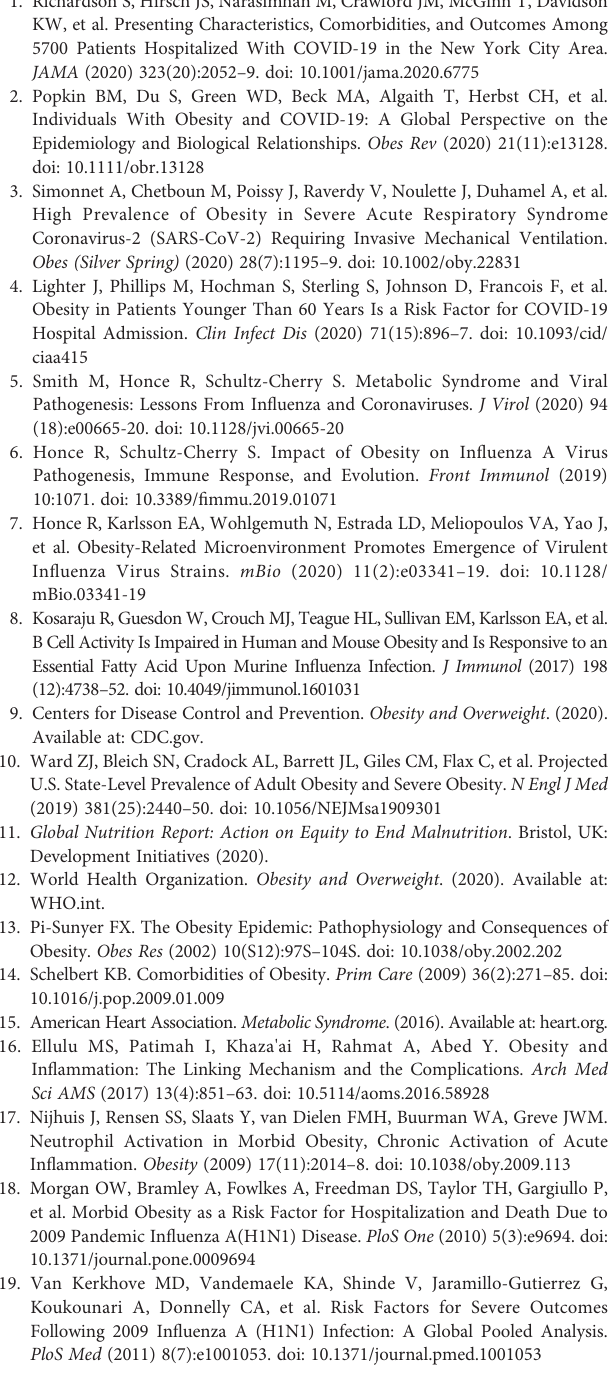
assess neutralizing antibody function. Neutralization curves at 8 and 30 DPI (A, G) show a slightly higher frequency of infected cells when virus was incubated with low serum dilutions derived from obese males, but nearly identical levels of infection are ultimately reached as the serum becomes more dilute. FRNT 50 and FRNT 90 values are nearly identical at each time point tested between wild type and obese male mice (B, C, E, F, H, I) . ns: not signi fi